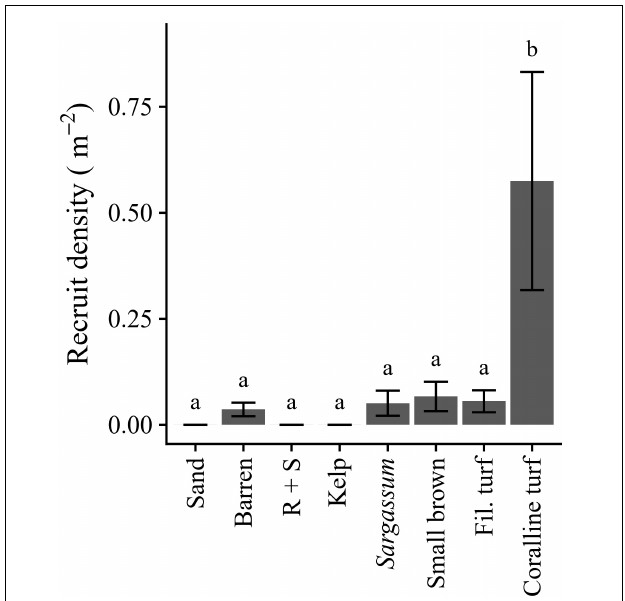
FIGURE 4 | Caulerpa filiformis recruit density ( ± SE) per habitat. Only sites with recruits present and habitats available at those sites ( n = 3, 4, 2, 3, 4, 4, 3, 4 for respective habitats) were included. Letters indicate differences according to post hoc comparison ( p < 0.05). See Table 1 for habitat